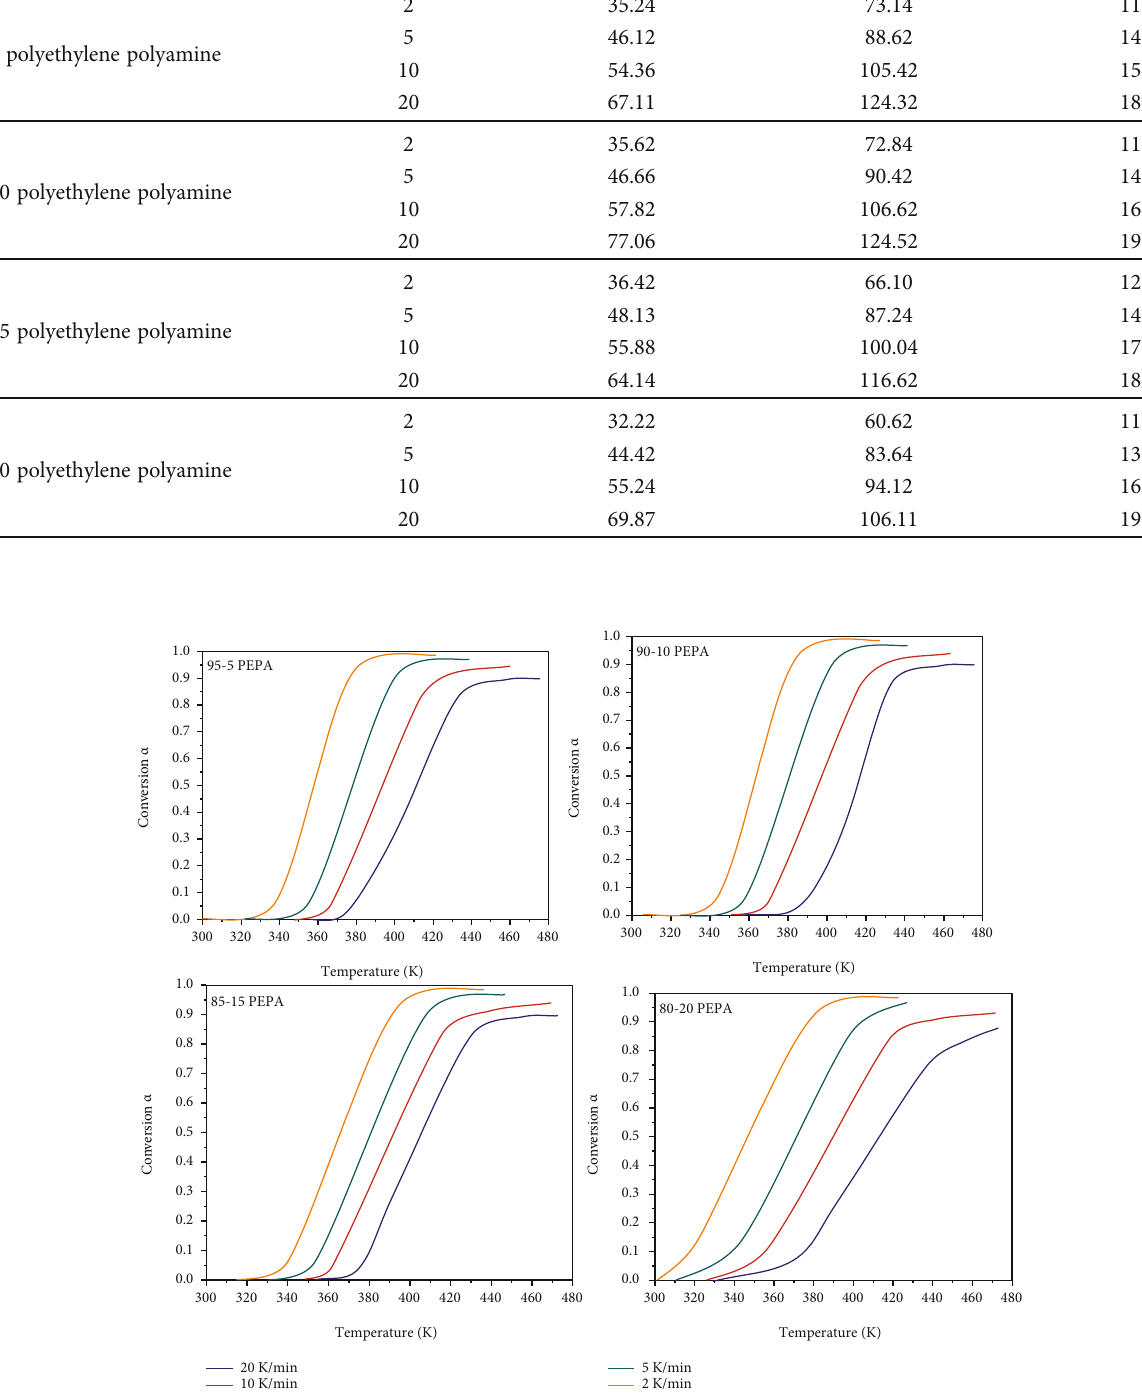
Figure 4: Polyethylene polyamine temperature vs. conversion curves at various heating rates: (a) 95-5; (b) 90-10; (c) 85-15; (d)